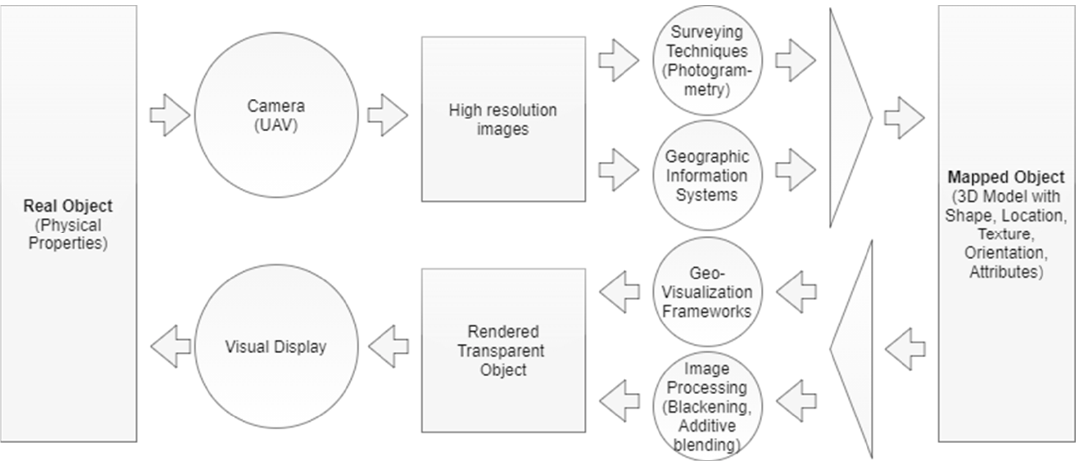
Figure 5. A Mixed Object generated by employing contemporary geospatial technologies. After being created, a Mapped Object may be further processed and rendered to the end-user visual display (object output device) through geovisualization frameworks (object output language) such as WebGL. As a result, the Real Object is still perceived by the end-user as a Real Object; however, it has technically been transformed into a Mixed Object. In fact, the Real Object is “merged” with an identical invisible digital object created by applying typical image processing techniques (blackening and additive blending). The physical properties of the Real Object are now connected with digital properties, therefore forming the Mixed Object.